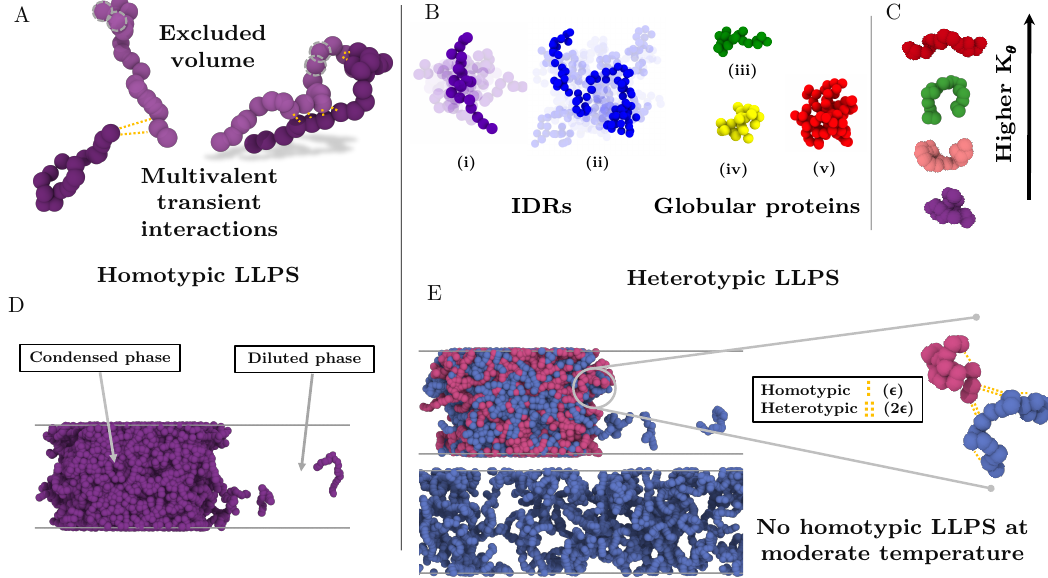
Figure 1. Minimal IDR coarse-grained model to investigate the impact of the conformational ensemble in LLPS. ( A ) Illustration of the coarse-grained protein model developed in this work with one bead representing a group of amino acids. The excluded volume interactions among beads are depicted with grey dashed circles, and the multivalent attracting interactions with yellow dashed lines. ( B ) Representative snapshots of the different types of IDRs studied. (i) Intrinsically disordered protein of N = 20. (ii) Intrinsically disordered protein of N = 80. (iii) Semi-compact globular protein of N = 20. (iv) Compact globular protein of N = 20. (v) Compact globular protein of N = 80. ( C ) Schematic representation of the impact of the angular constant ( K θ ) in the representative configuration of the coarse-grained IDRs of N = 20. Higher K θ implies conformational landscapes enriched in extended states while lower ones enhance the emergence of structures preferentially collapsed. ( D ) Snapshot of a direct coexistence simulation in which LLPS is driven by homotypic interactions. ( E ) Sketch of a binary mixture direct coexistence simulation where LLPS is driven by heterotypic interactions, phase separation takes place in presence of a high affinity partner. Multivalent interactions between proteins of the different type (heterotypic) are twice more attractive (2 (cid:101) ) than those among proteins of the same type ( (cid:101)